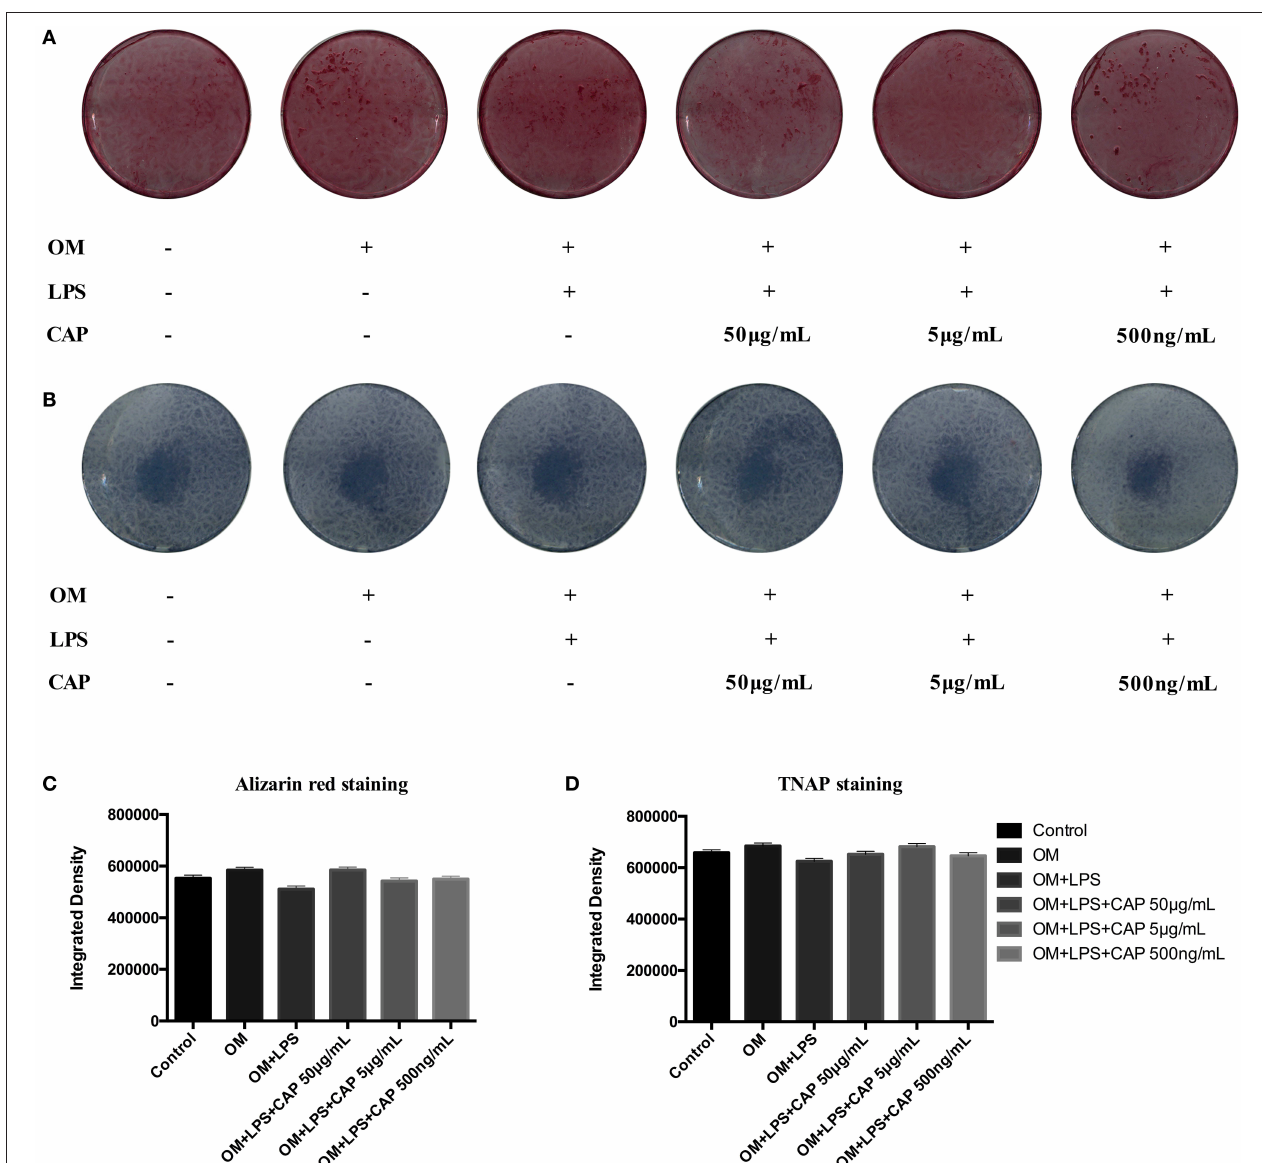
FIGURE 4 | The results of Alizarin red staining (A) and TNAP staining assay (B) showed the odontogenic ability of CL, and the results of quantitative analysis (C,D) showed the differences were not significant ( p > 0.05). OM represented osteogenic medium.